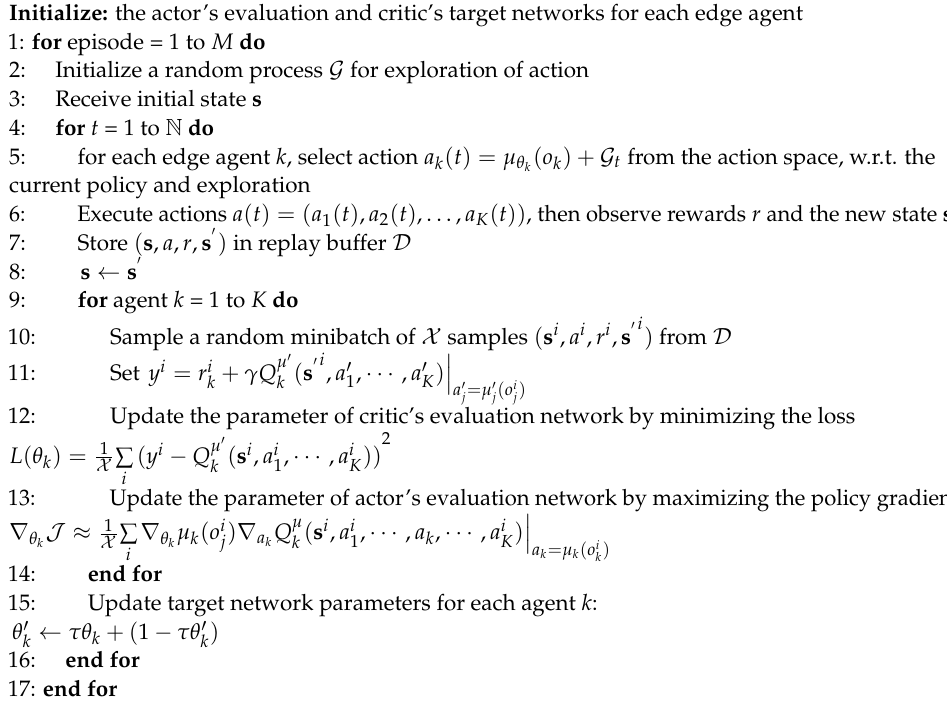
Algorithm 1 is the pseudo-code of our given MADDPG algorithm for the SSASGEC problem. The details of the proposed MADDPG algorithm are described as follows. Algorithm 1. Multi-agent deep deterministic policy gradient algorithm for the SSASGEC problem. Initialize: the actor’s evaluation and critic’s target networks for each edge